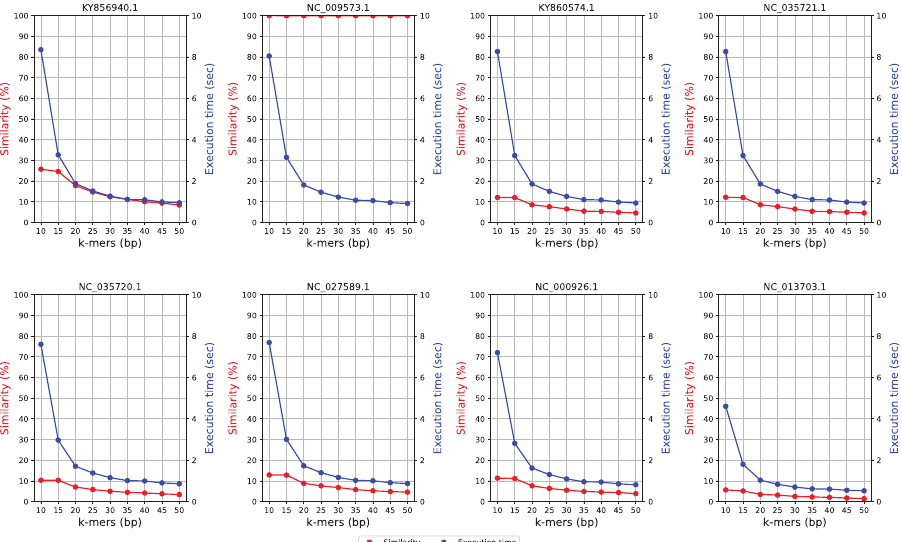
Figure 1. Similarity and execution time of read alignment by k -mer